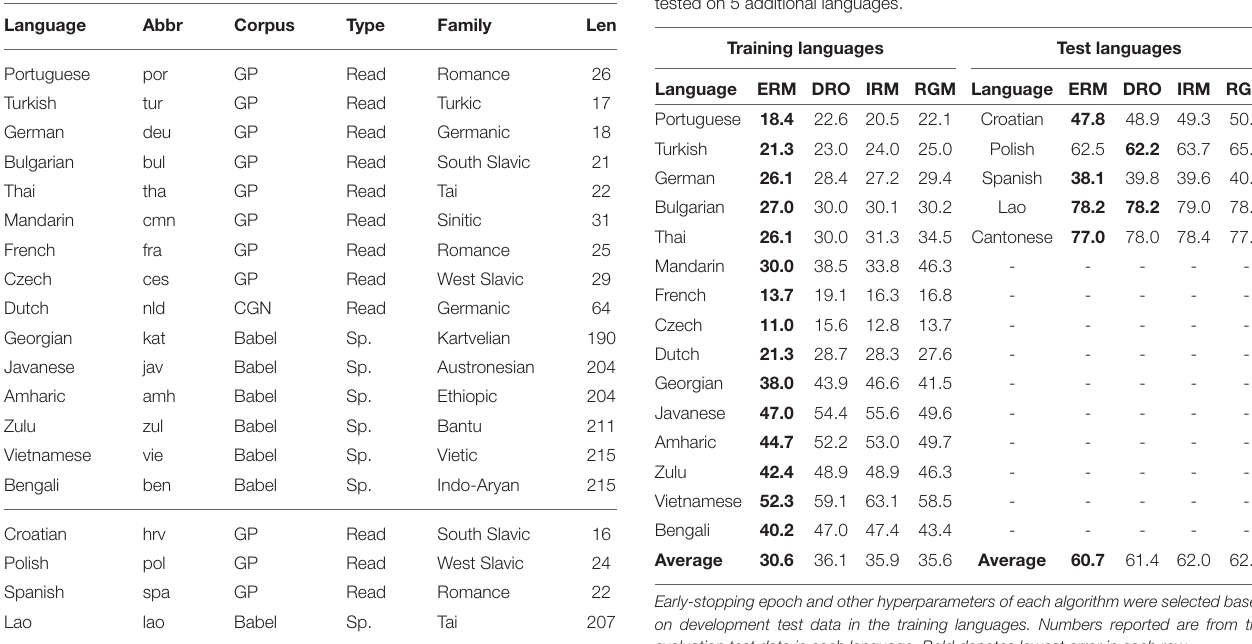
TABLE 2 | Phone token error rates (PTER, %) of an ASR trained on 15 languages, tested on 5 additional languages. Training languages Test